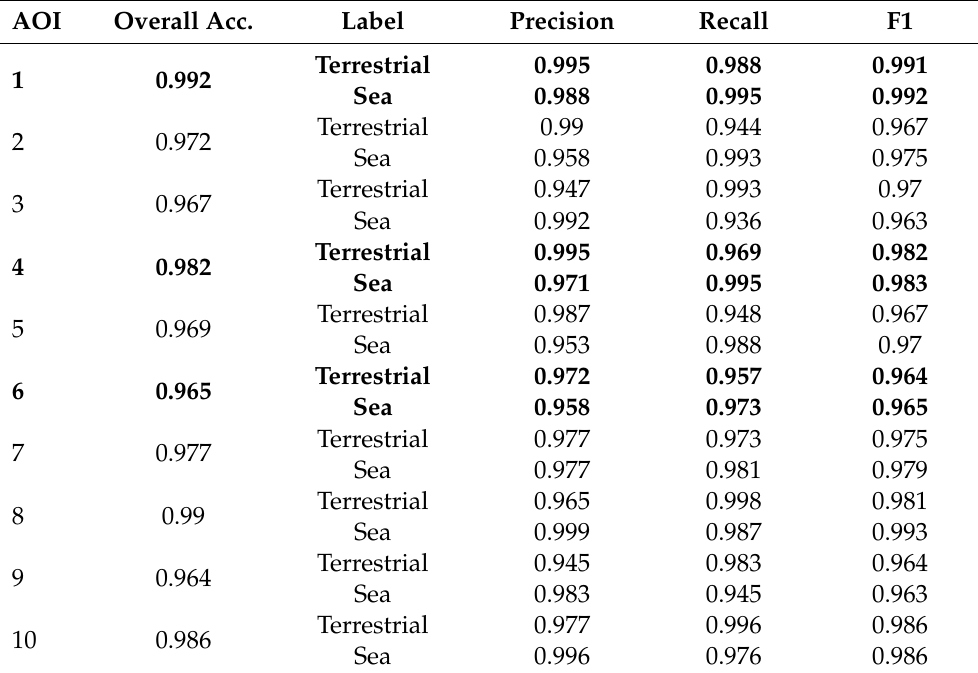
Table 3. Accuracy statistics within a 500 m buffer around the manually digitized reference coastline for the final combined binary classification map after post-processing. Precision, recall, and F 1 -scores are given for both classes, terrestrial area (including inland lakes and rivers) and sea, and each aoi. Validation sites are marked in bold text. Accuracy measures are rounded to the third decimal place. AOI Overall Acc. Label Precision Recall